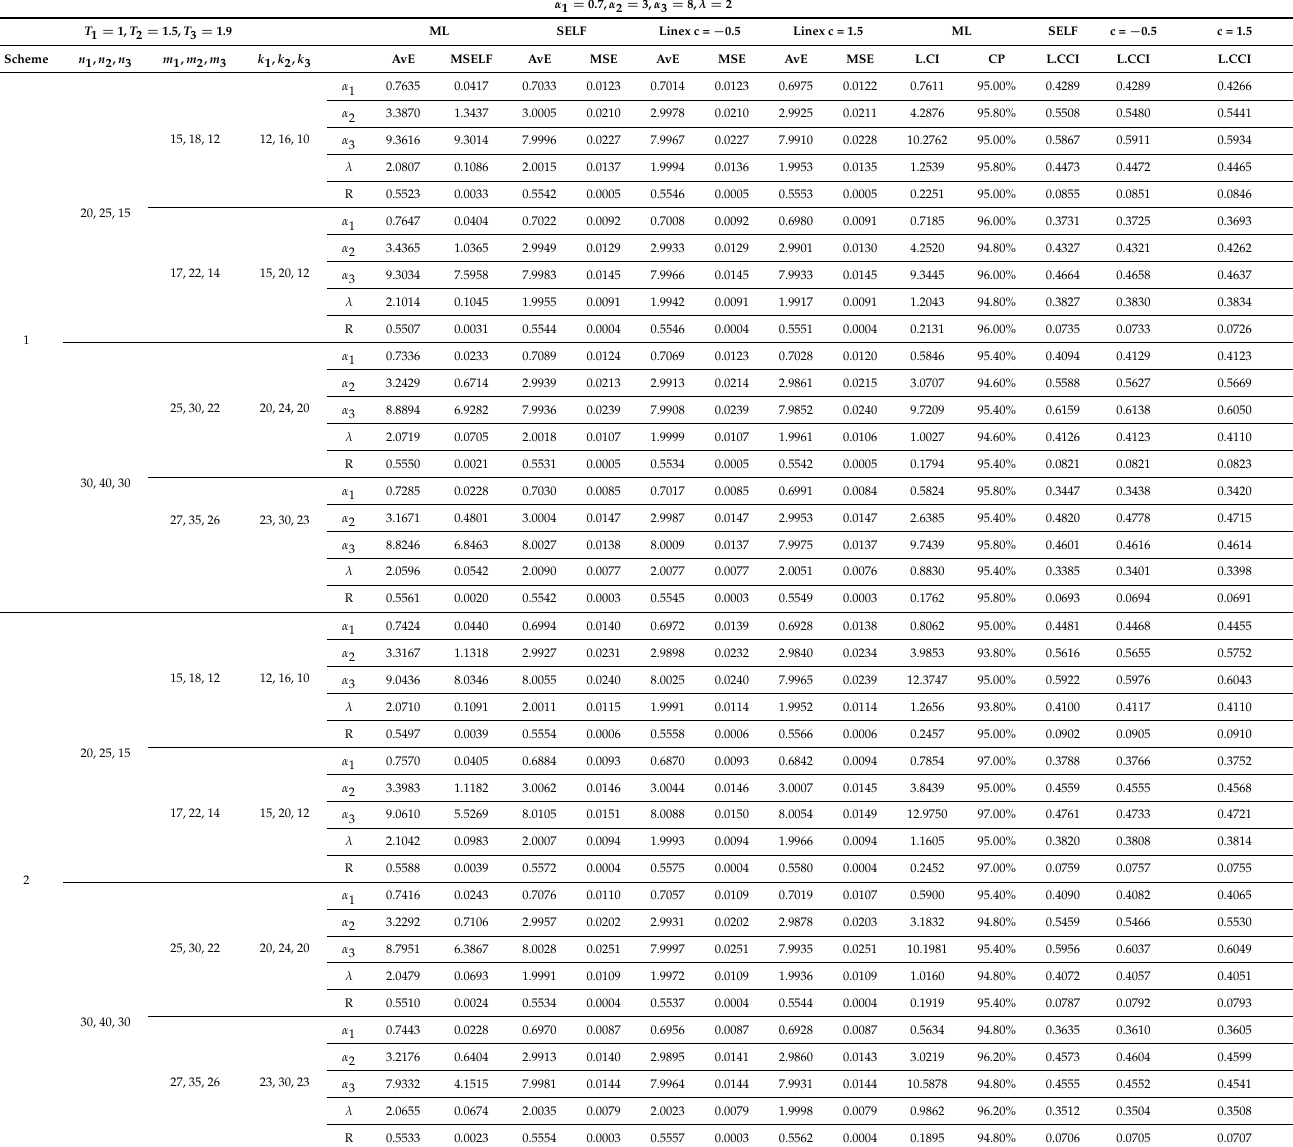
Table 5. AvE and MSE for estimation methods: Case